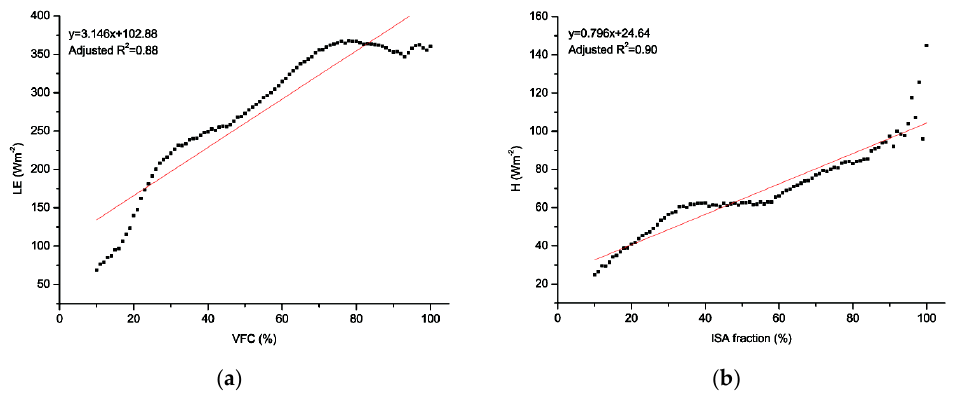
Figure 8. Scatterplots of ( a ) mean LE versus vegetation coverage and ( b ) mean H versus percentage of ISA.